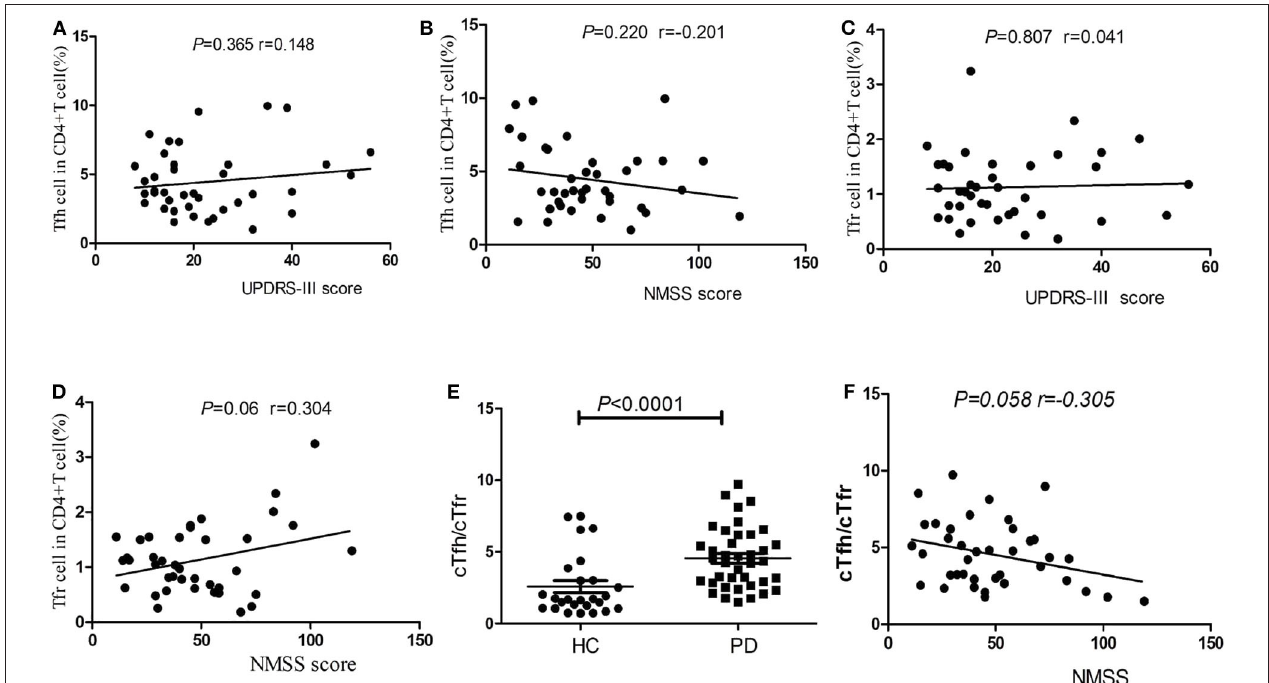
FIGURE 3 | Correlation analysis of cTfh, cTfr and cTfh/cTfr for clinical symptoms. (A) The correlation analysis of the percentages of cTfh cells in PD patients with disease severity (UPDRS-III score) ( P > 0.05). (B) The correlation analysis of the percentages of cTfh cells in PD patients with nonmotor symptoms (NMSS) ( P > 0.05). (C) The correlation analysis of the percentages of cTfr cells in PD patients with disease severity (UPDRS-III score) ( P > 0.05). (D) The correlation analysis of the percentages of cTfr cells in PD patients with nonmotor symptoms (NMSS) ( P > 0.05). (E) A comparison of the cTfh/cTfr cells in PD patients and HCs. The cTfh/cTfr ratio in PD patients was significantly higher than that in HCs ( P < 0.0001). (F) The correlation of the cTfh/cTfr ratio and NMSS in PD patients showed no statistical significance ( P =